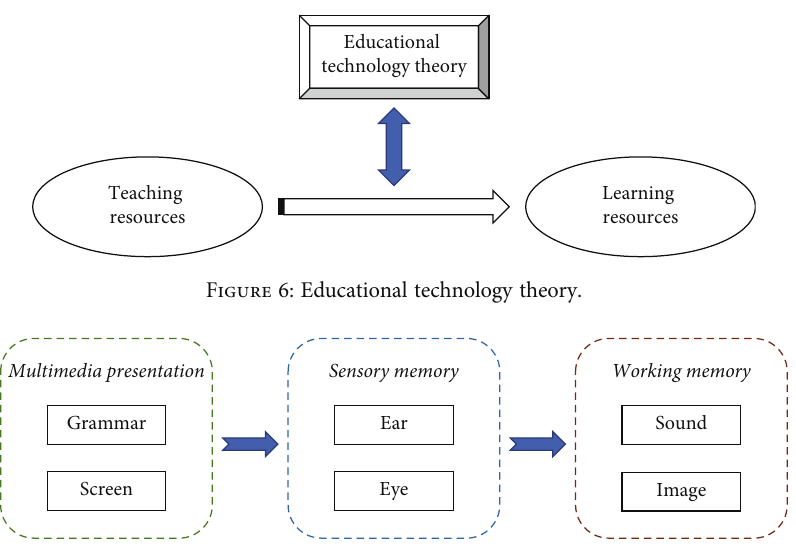
Figure 7: Cognitive theoretical model of multimedia